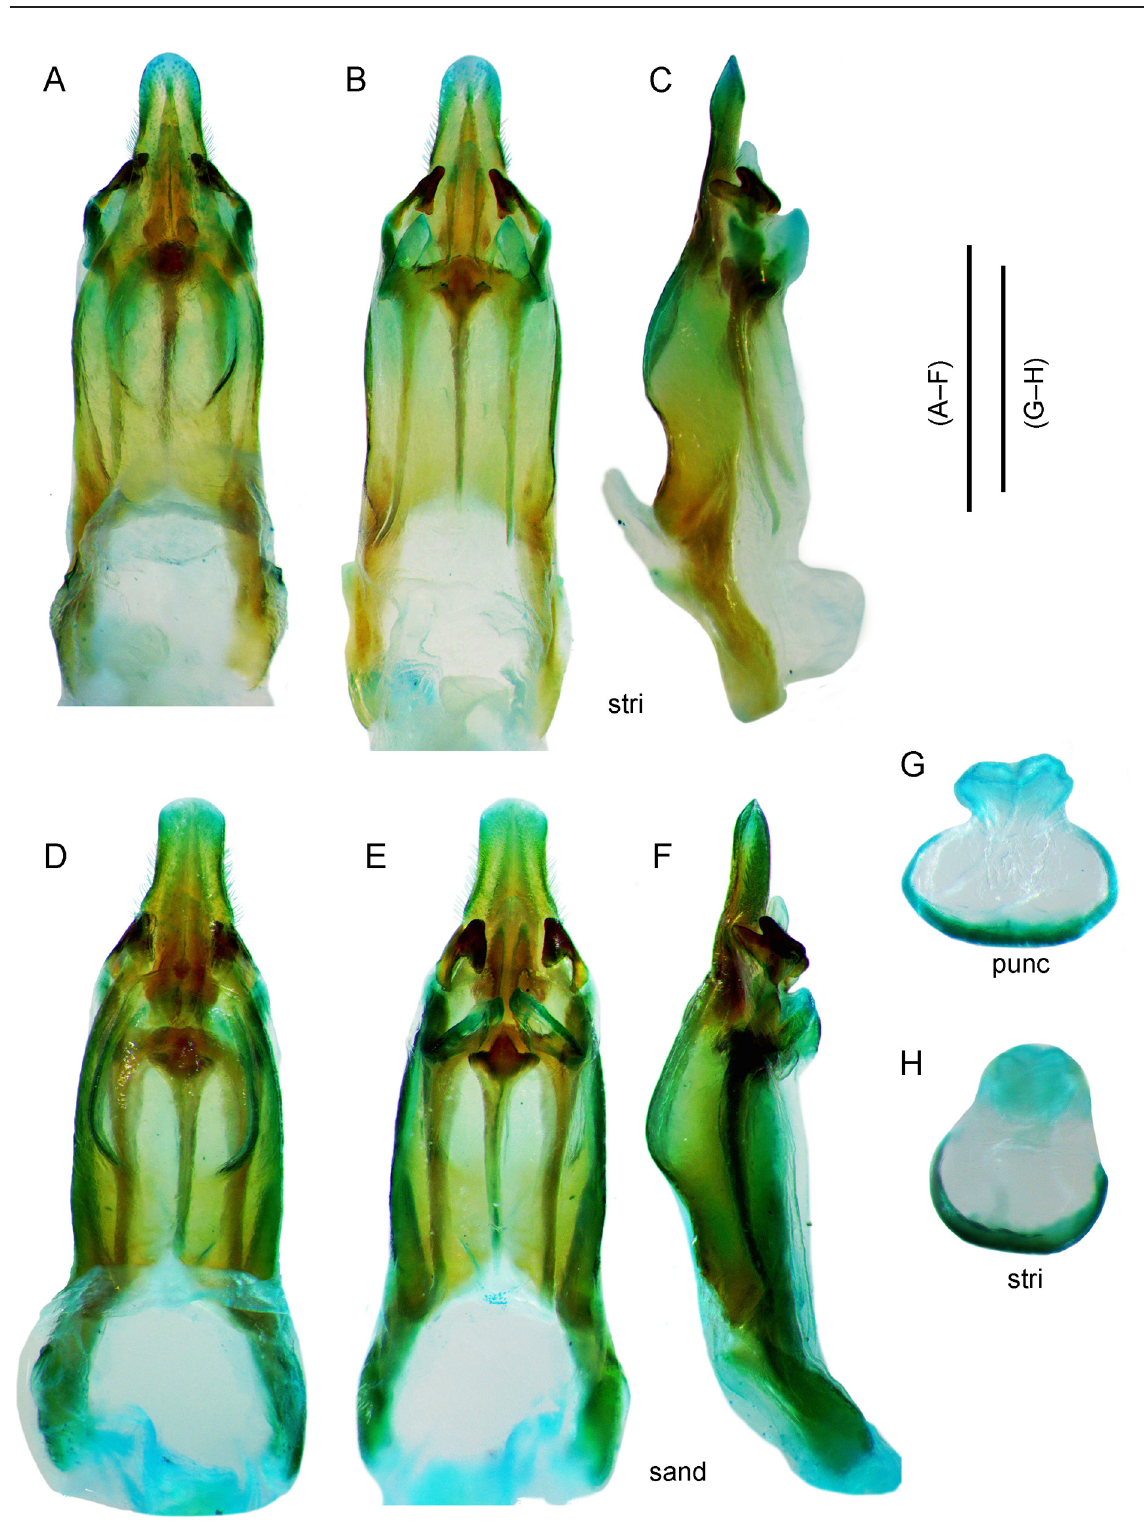
Fig. 8. Genitalia. A–F . ♂♂. G–H . ♀♀. A–C, H . Platybinthus striolatus (Brunner von Wattenwyl, 1898) gen. et comb. nov. (ZIN). D–F . Platybinthus sandyi gen. et sp. nov., holotype (MZB.ORTH.1786) G . Platybinthus punctatus (Brunner von Wattenwyl, 1898) gen. et comb. nov., syntype (MNHN-EO- ENSIF1448). Scale bars: A–F = 1 mm; G–H = 0.5